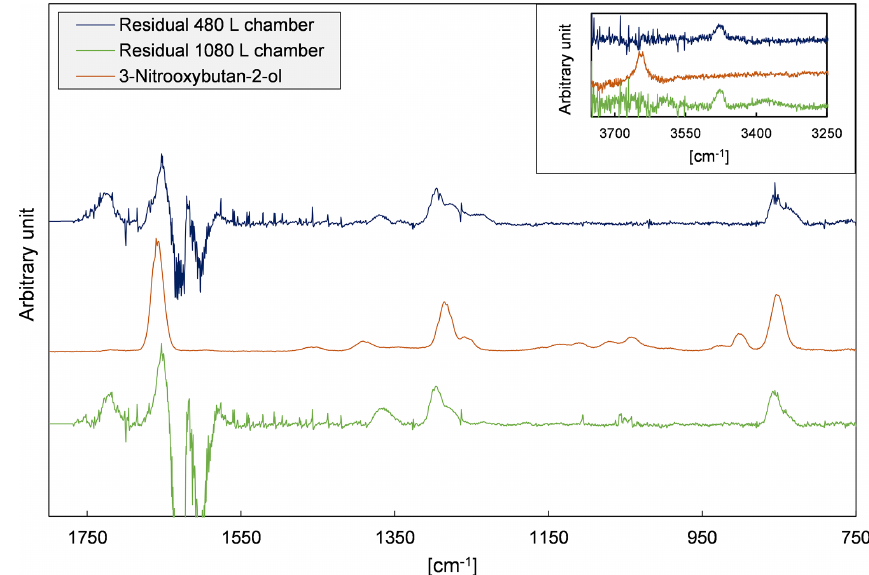
Figure 5. Residual spectra of 4M3P2 + OH product study experiments performed in both chambers after subtraction of all identified species and an exemplary reference spectrum of an organic nitrate recorded in our laboratory (Spittler,